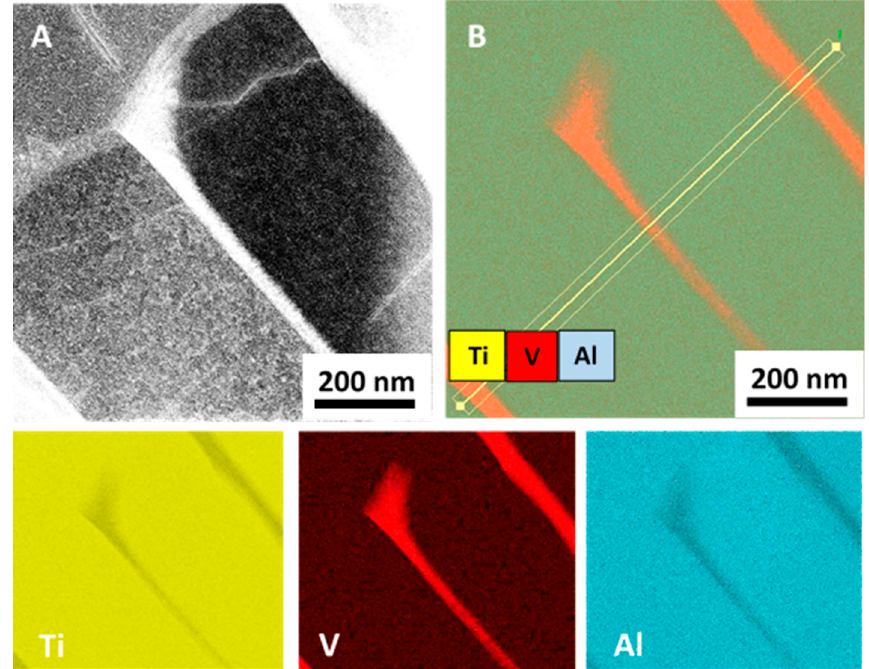
grain boundaries: ( A ) STEM Dark-Field image; ( B ) EDS map for Ti, Al, and V. EDS maps of single Figure 5. Energy-dispersive spectroscopy (EDS) analysis of sample #TT in correspondence to three elements are also reported for Ti, V, and grain boundaries: A ) STEM Dark-Field image; B ) EDS map for Ti, Al, and V. EDS maps of single elements are also reported for Ti, V, and Al.